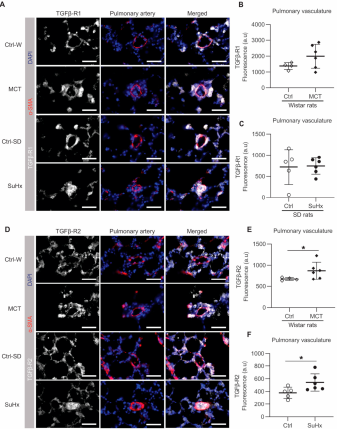
Figure 2. Immunofluorescence in pulmonary vasculature. ( A ) Representative images of immunofluo- rescence for transforming growth factor- β receptor 1 (TGF β R1); white = TGF β R1; red = α -SMA; blue = nuclei. ( B , C ) show the quantification data of TGF β R1 expression within the area co-stained with α -SMA; ( D ) representative immunofluorescent images for TGF β R2; white = TGF β R2; red = α -SMA; blue = nuclei; ( E , F ) shows the quantification data of TGF β R2 expression within the area co-stained with α -SMA. Ctrl: control rats, MCT: monocrotaline rats, SuHx: sugen–hypoxia rats, SD rats: Sprague Dawley rats, α -SMA=alpha smooth muscle actin. Scale bar = 50 µ m. Wistar rats: n(ctrl) = 4, n(MCT) = 6. SD rats: n(ctrl) = 5, n(SuHx) = 6. * p <